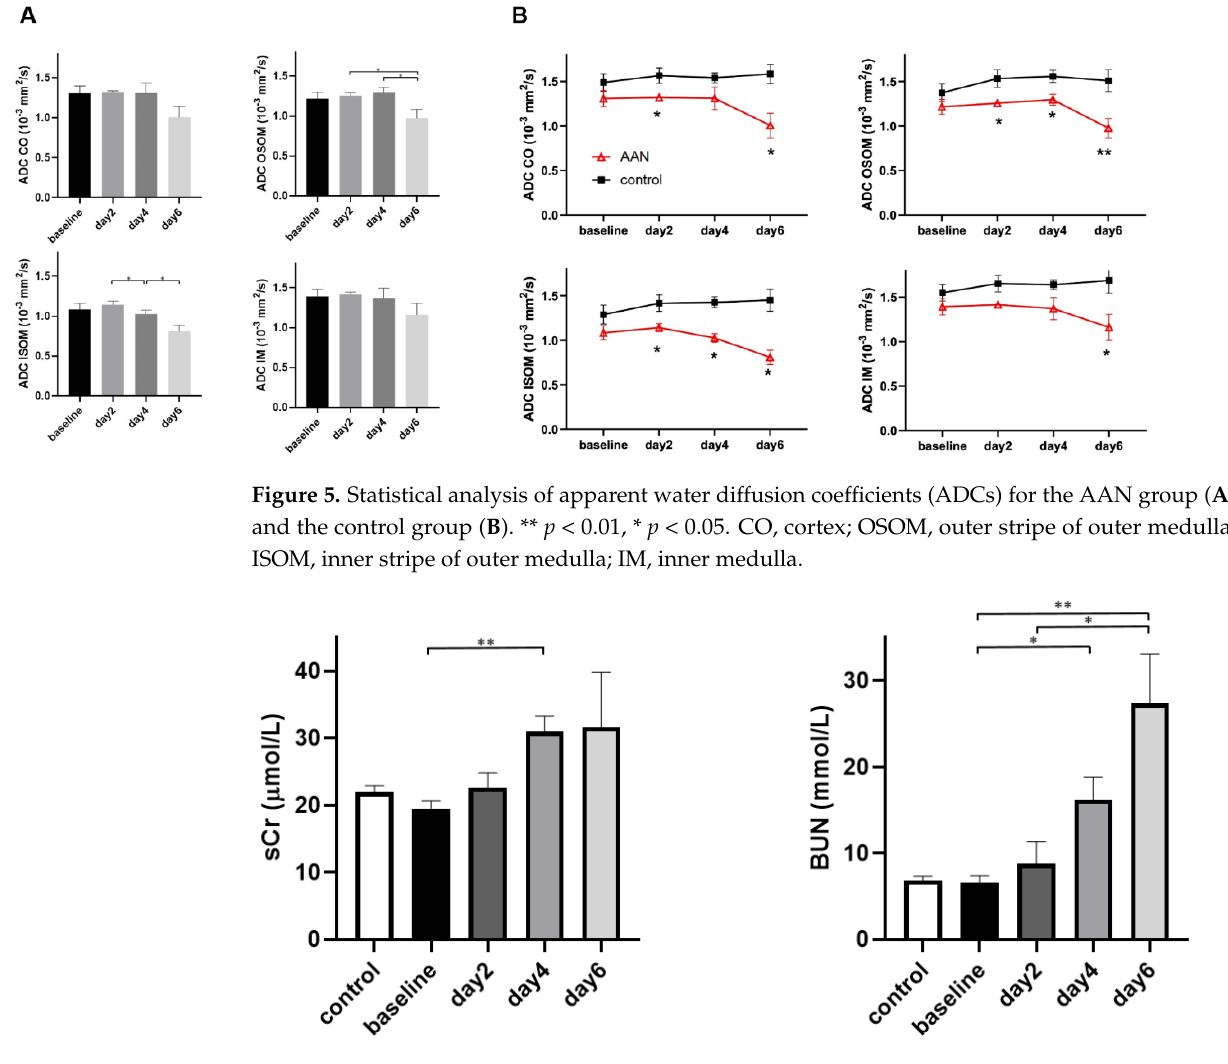
Figure 6. Serum creatinine levels (sCr) ( left ) and blood urea nigrogen (BUN) ( right ) of the control group and the AAI group. ** p < 0.01, * p < 0.05.